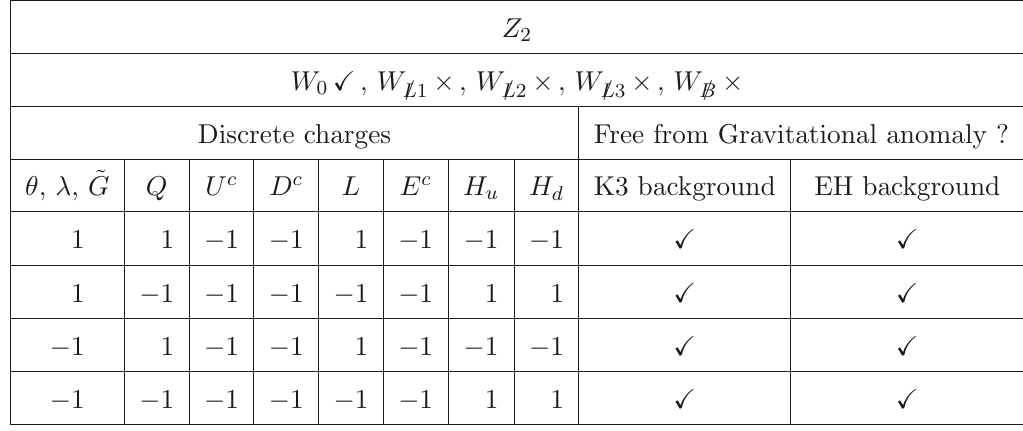
Table 2 . The columns 1 − 8 show the discrete Z 2 charges of the superspace θ coordinate as well as the MSSM superfields. The discrete charge Z 2 ( θ, λ, ˜ G ) = 1 ( − 1) of the θ coordinate, gauginos and gravitino corresponds to a non- R discrete symmetry (discrete R -symmetry). The charges of the MSSM superfields are obtained by demanding that there are no mixed anomalies of the form Z 2 − SU( N ) − SU( N ) ( N = 2, 3), and subject to the constraint that only the terms in W 0 are allowed. The columns 9 and 10 show whether the discrete symmetry (defined by the charges given in columns 1 − 8) is expected to be violated by gravitational anomalies in the backgrounds of K3 and Eguchi-Hanson instantons respectively. Note that, the solutions obtained for Z 2 ( θ, λ, ˜ G ) = 1 and − 1 are the same in this case. See text for more